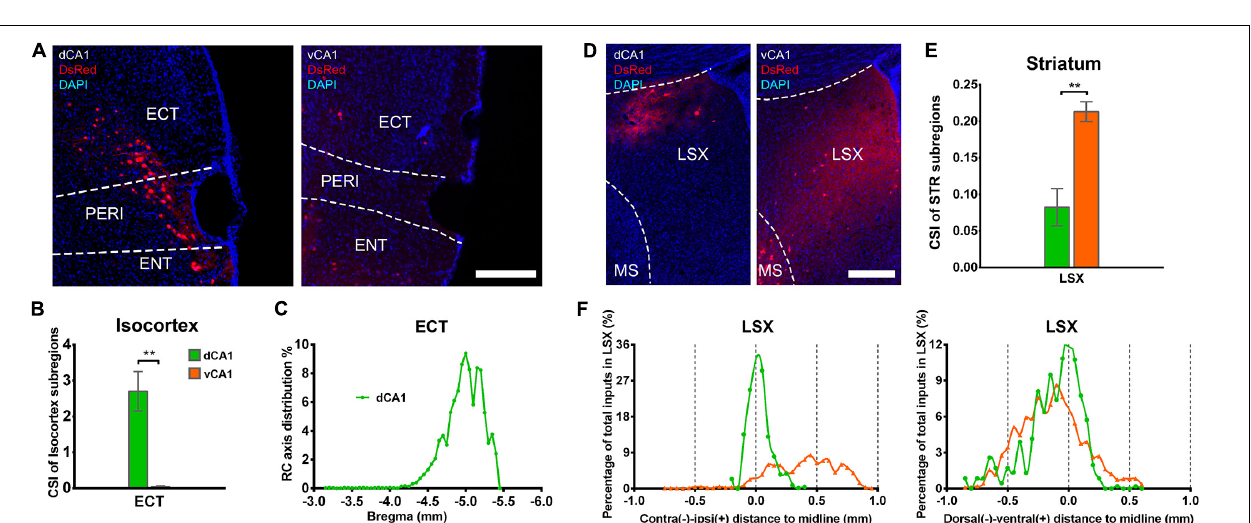
FIGURE 7 | Distribution patterns of bilateral isocortex and STR inputs between the two CA1 tracing groups. (A) Representative images showing labeling of monosynaptic inputs to the dorsal or ventral CA1 PNs in ipsilateral ECT. Scale bar: 250 µ m. (B) CSI of the bilateral inputs in ECT. (C) Distribution patterns of the bilateral input neurons to dorsal CA1 PNs along the RC axis in ECT. (D) Representative images showing LSX inputs to the dorsal or ventral CA1 PNs. Scale bar, 250 µ m. (E) CSI of the inputs in bilateral STR subregions-LSX. (F) The contralateral-ipsilateral and dorsal-ventral distribution patterns of monosynaptic inputs in LSX of two tracing groups. ** P <